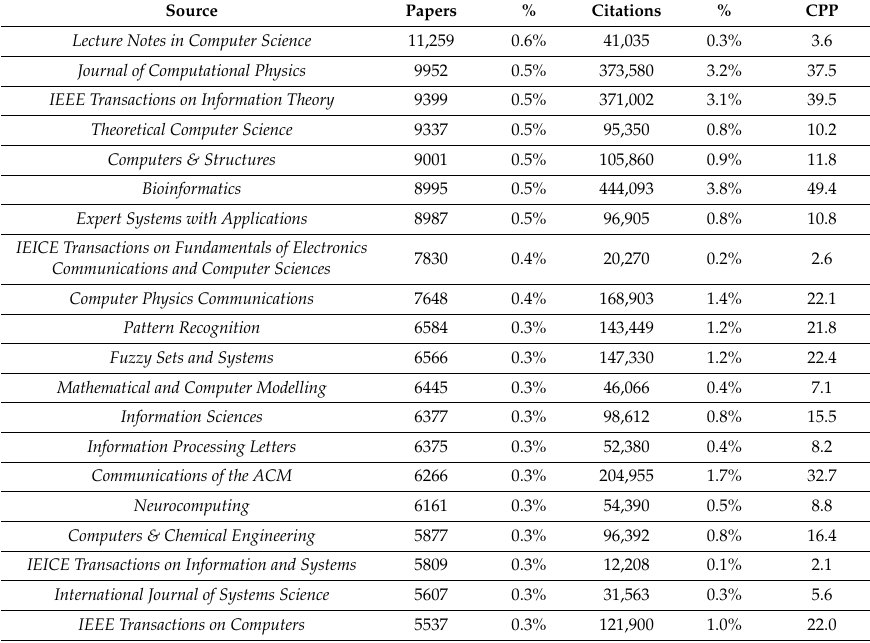
Table 6. Top 20 sources and their papers, citations, and citations per paper